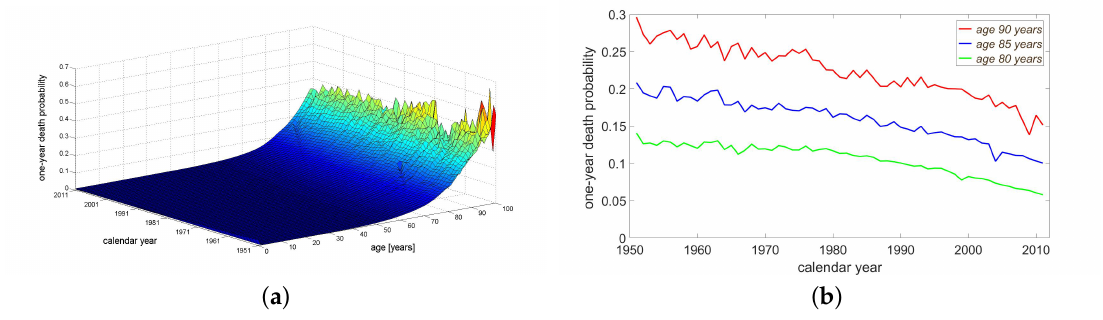
Figure 1. U.K. Mortality Tables ( a ) and One-Year Death Probabilities ( b ) of Men